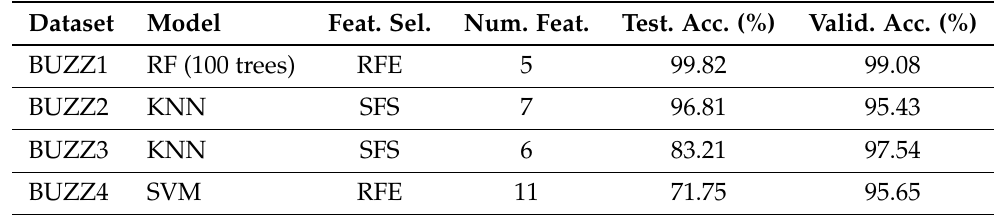
Table 6. Datasets, models, feature selection methods (Feat. Sel.), numbers of features (Num. Feat.), and test and validation accuracies on BUZZ1, BUZZ2, BUZZ3, BUZZ4.